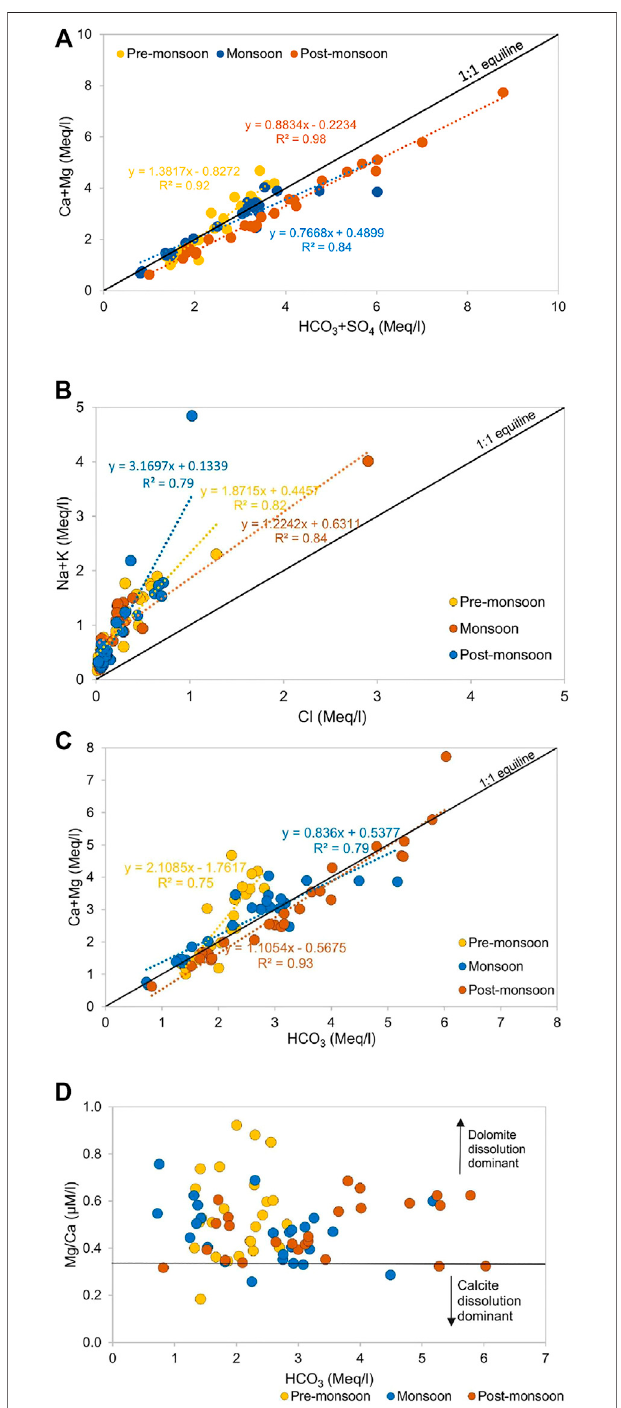
FIGURE8| Scatterplotof (A) HCO 3 +SO 4 versusCa+Mg, (B) Clversus Na + K, (C) HCO 3 versus Ca + Mg, and (D) HCO 3 versus Mg/Ca revealing predominance of dolomite